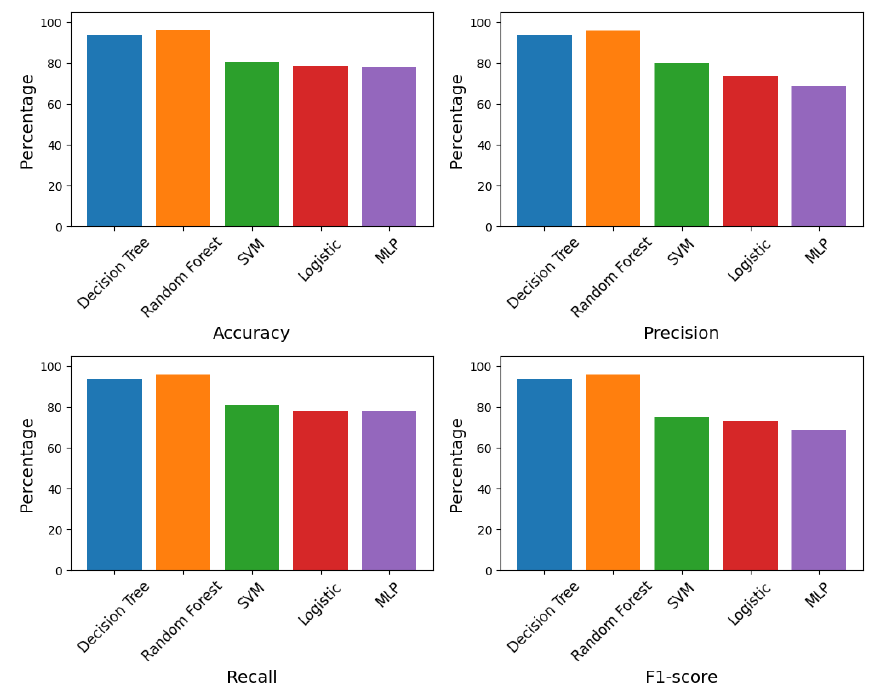
Figure 3. The accuracy, precision, recall and F1-score of AFH map prediction results for the